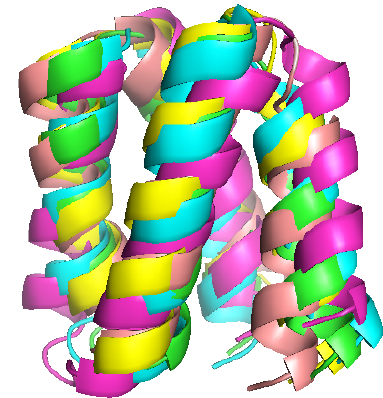
Figure 8. Superposition of five modeled structures (R5, R1, I5, I4, and I2) that produce 2D-PDPA scores of less than 0.80 exhibits an average 2.53 Å